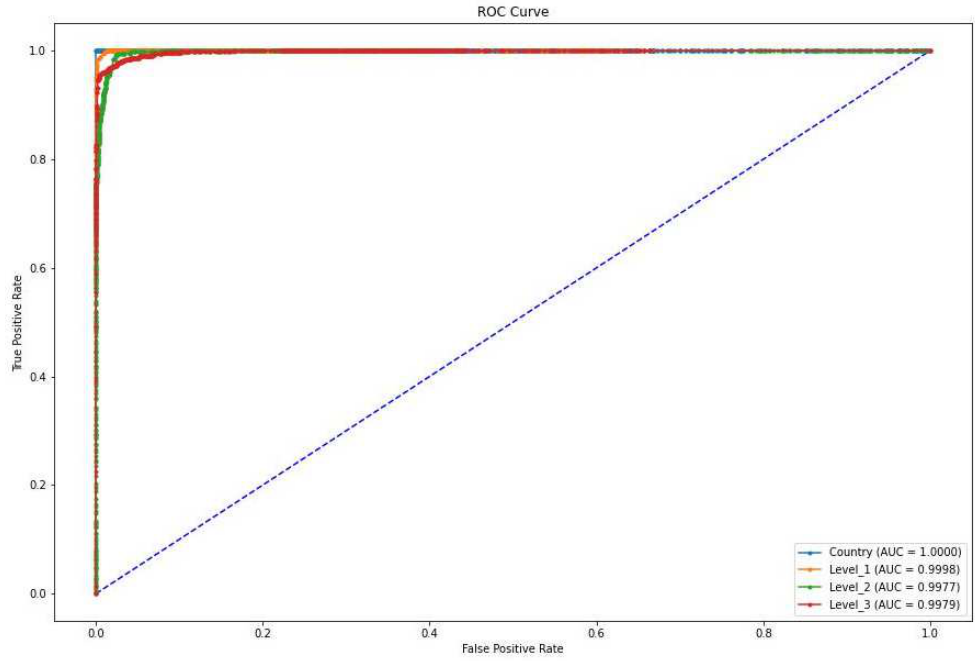
Figure 6. The Receiver Operating Characteristics (ROC) Curve.